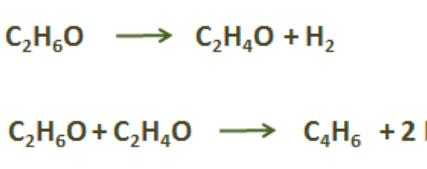
Figure (cid:561) 9. (cid:561) Schematic (cid:561) chart (cid:561) of (cid:561) C 4 H 6 (cid:561) production (cid:561) methods. (cid:561)